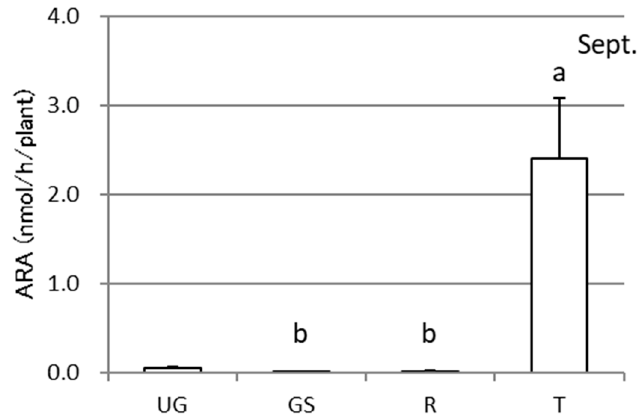
Figure 5. Total acetylene reduction activities (ARA) in different plant parts of sweet potatoes (Sa-B) at one measurement time point, September, over the course of cultivation in an experimental field. UG, GS, R, and T represent the aboveground, underground stem, root, and tuber, respectively. The error bars indicate standard errors ( n = 5), and different letters indicate significant differences at P < 0.05 by Tukey’s test.